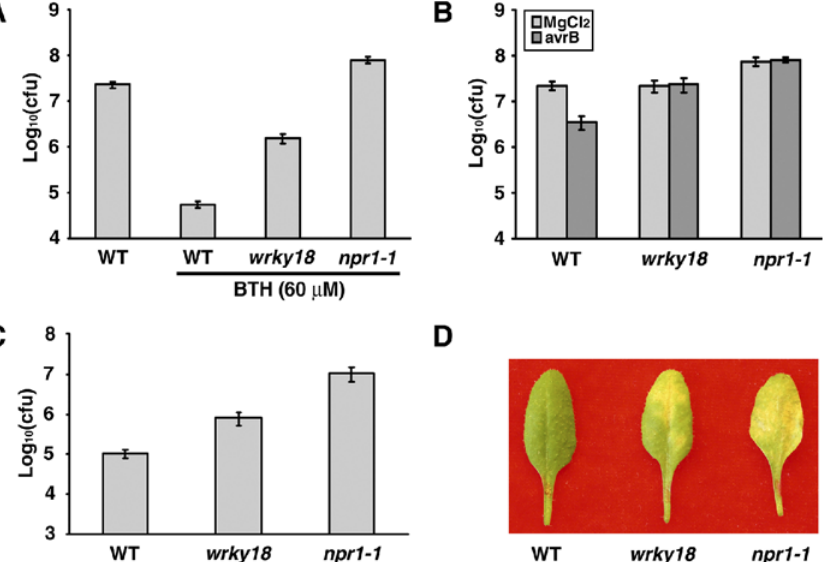
Figure 3. Resistance Defects of wrky18 (A) Plants were chemically induced with 60 l M BTH 24 h before inoculation with a high dose of Psm ES4326 (OD 600 ¼ 0.001). As a control, uninduced plants were inoculated at the same time. Bacterial growth was scored 3 dpi. Each datapoint represents the average colony-forming units (cfu) from 16 leaf disks plotted on a log scale, with error bars indicating 95% confidence intervals. This experiment was repeated more than five times with similar results. (B) Plants were first inoculated with either P. syringae pv. phaseolicola avrB or 10 mM MgCl 2 on two lower leaves. Later (3 d), three upper leaves were inoculated with Psm ES4326 (OD 600 ¼ 0.001). Leaf disks from the second inoculation were collected 3 dpi to measure bacterial growth. This experiment was carried out twice with similar results. (C and D) To examine wrky18 for an EDS phenotype, plants were inoculated with a low dose of Psm ES4326 (OD 600 ¼ 0.0001). Bacterial growth was measured in 3 dpi (C), and disease symptoms were recorded in (D) 3 dpi. These experiments were performed more than five times with similar results.